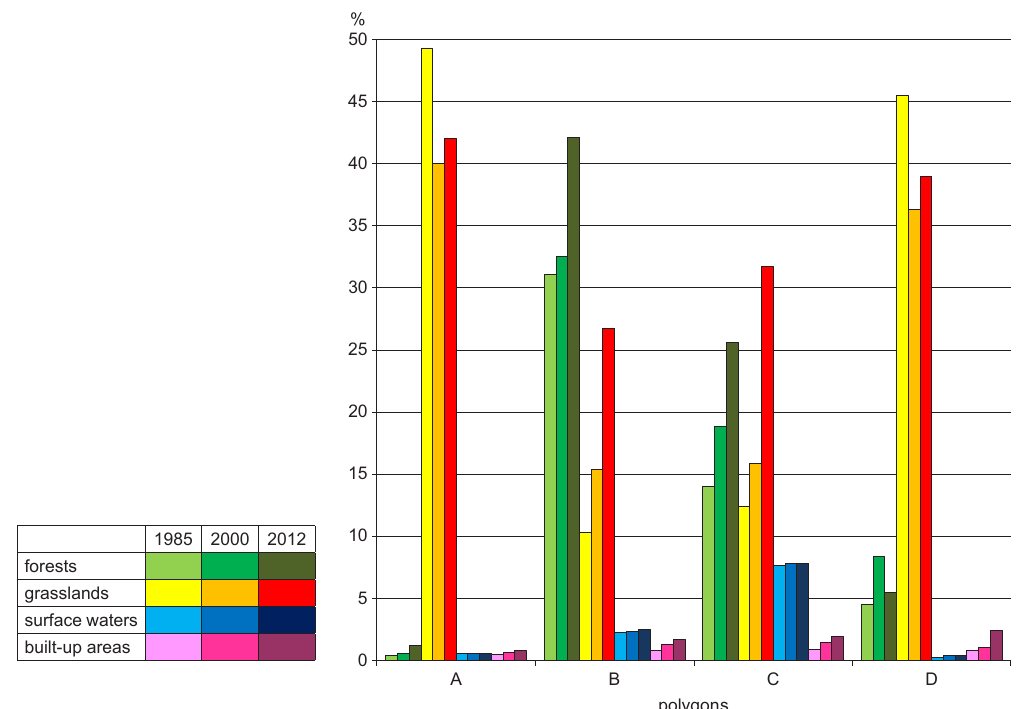
Fig. 3. Percentage of area occupied by selected forms of land cover in testing grounds in 1985, 2000 and 2012. Source: own study.